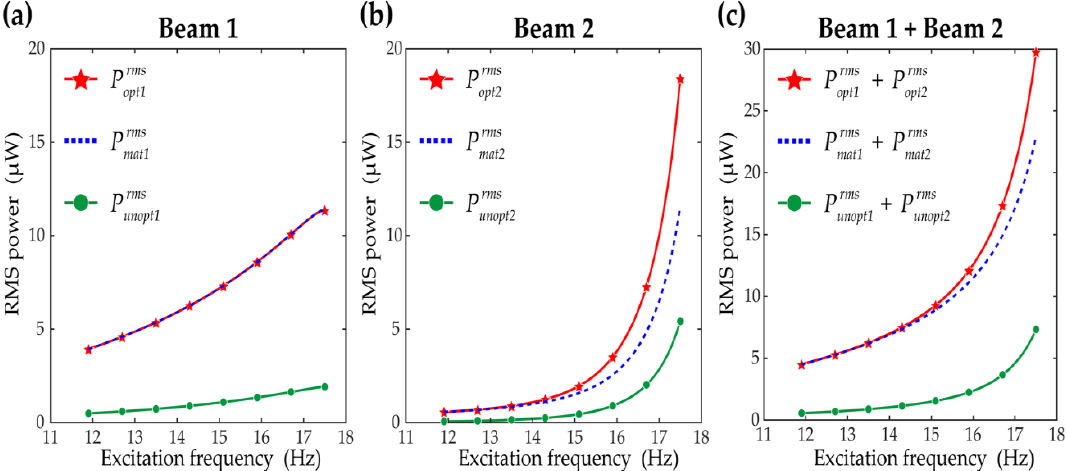
Figure 8. Root mean square (RMS) power output results of ( a ) beam 1 and ( b ) beam 2, and ( c ) total RMS output power results of the two beams. The red lines with the stars are the results obtained with the optimal load resistances considering the third-harmonic distortion. The blue dotted lines are the results obtained by applying the impedance matching technique considering the fundamental component only. The green lines with the circles are the RMS power output evaluated with the resistance of 1 M Ω without load resistance optimization. The excitation frequencies are increased from 11.9 Hz to 17.5 Hz with increments of 0.1 Hz, and the base acceleration was set to be 6 m/s 2 .